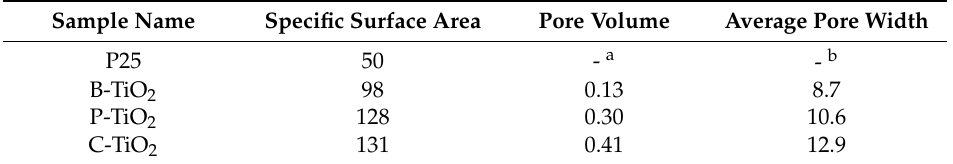
Figure 8. Nitrogen adsorption–desorption isotherms and the corresponding pore-size distributions (the inset) of X-TiO 2 (X = B, P, C) samples made with equivalent amount of TBOT (3 vol %). Table 1. Specific surface area, pore volume, and pore-size distribution of the